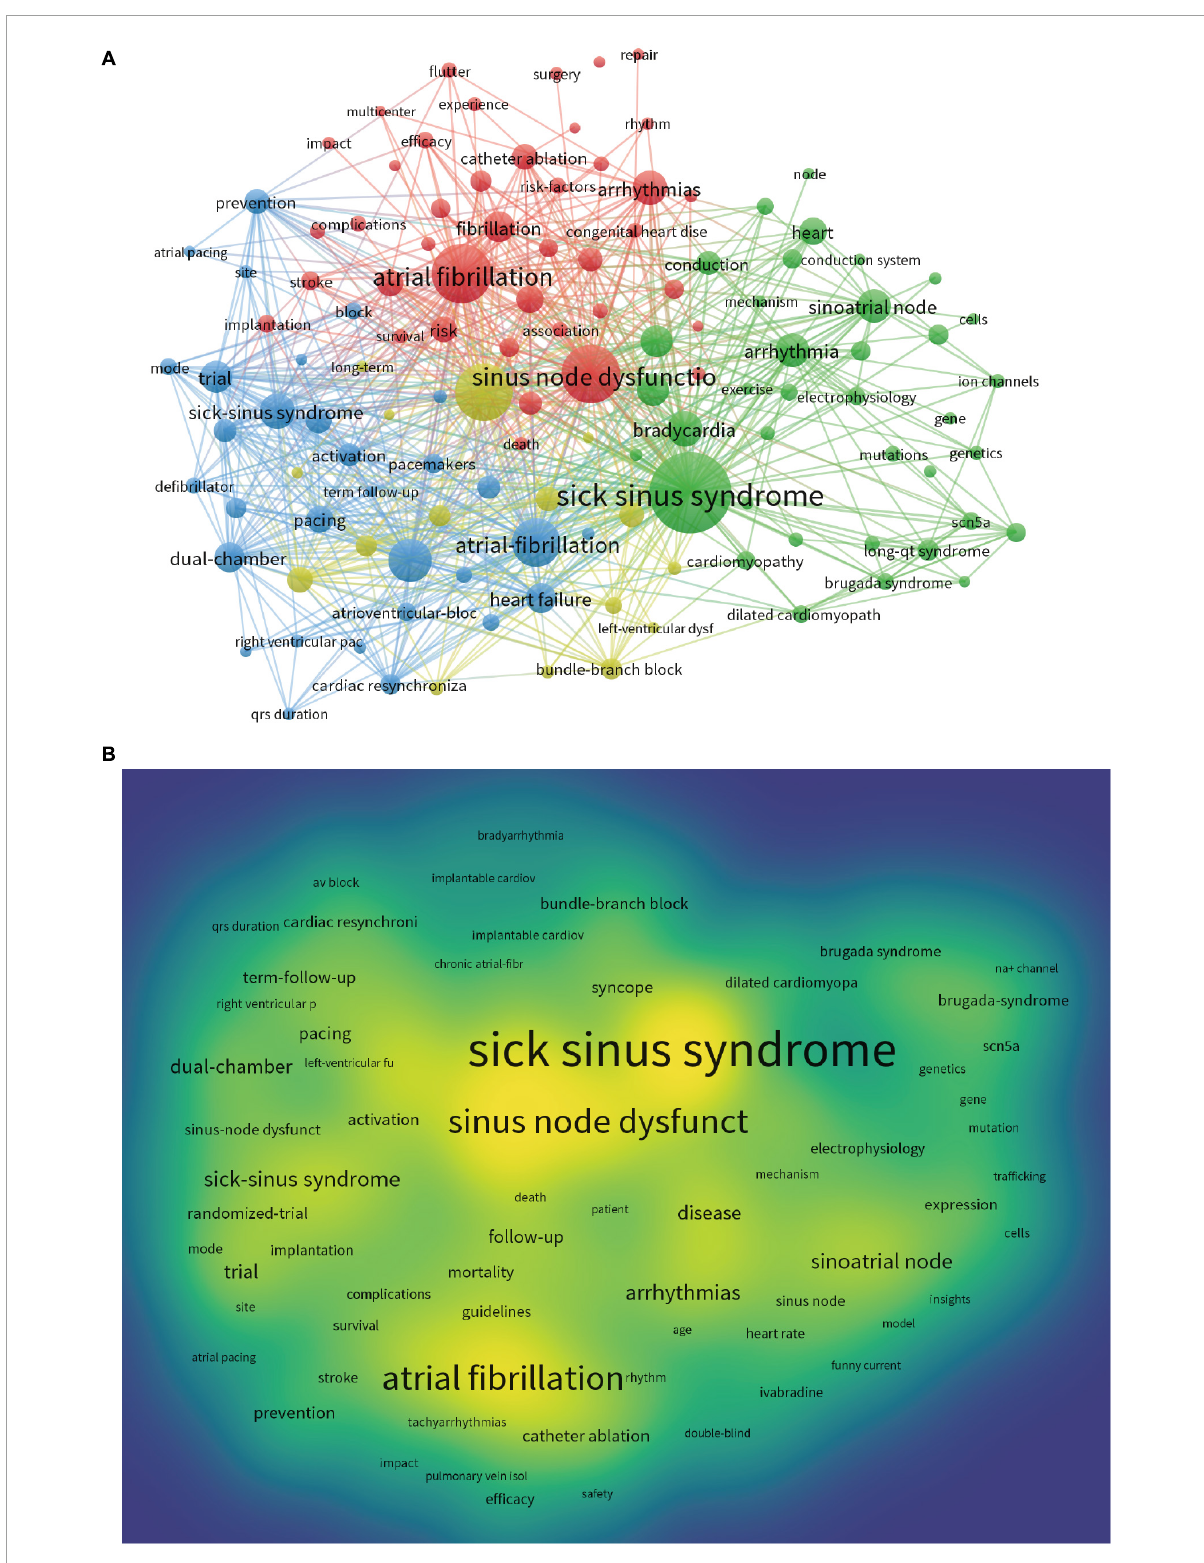
FIGURE5 (A) Network map of keywords analysis based on VOS viewer. (B) Density map of keywords analysis based on VOS